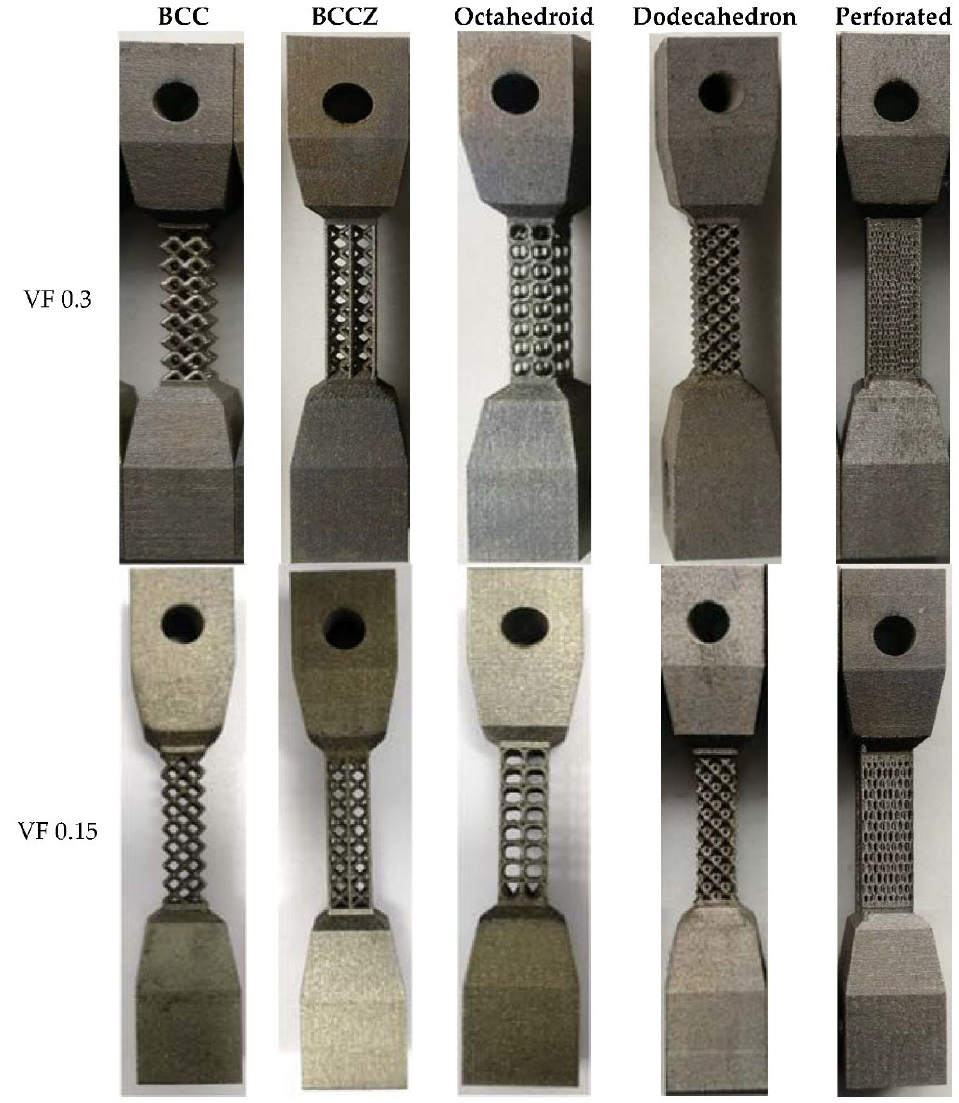
Figure 9. Printed test sample with two different volume